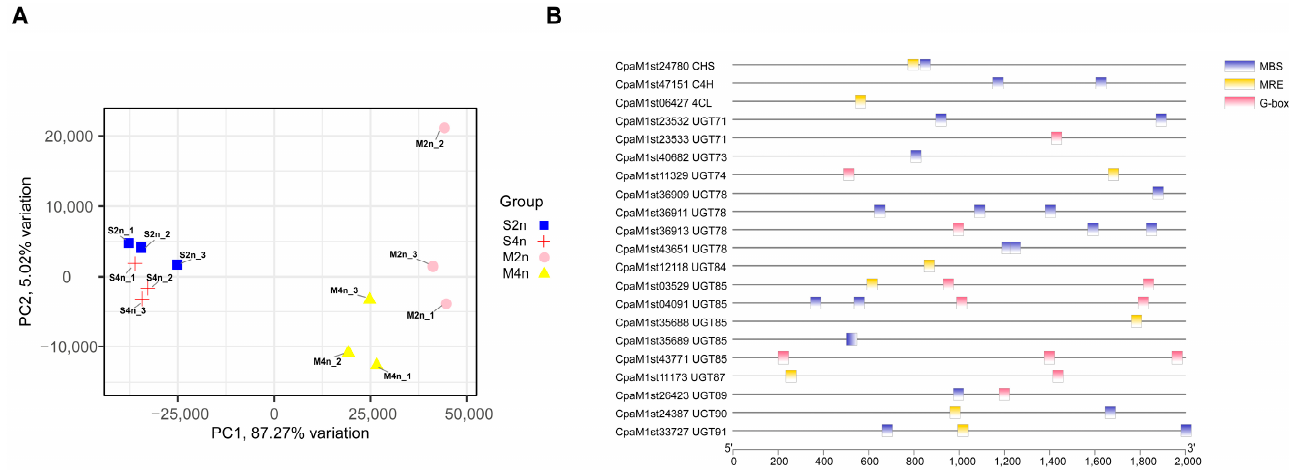
Figure 3. ( A ) PCA score plot of RNA-seq data in the leaf obtained from different C. paliurus ploidies, and each point in the PCA score plot represents an independent biological replicate; and ( B ) cis - regulatory element analysis of key genes involving flavonoid glycoside biosynthesis.